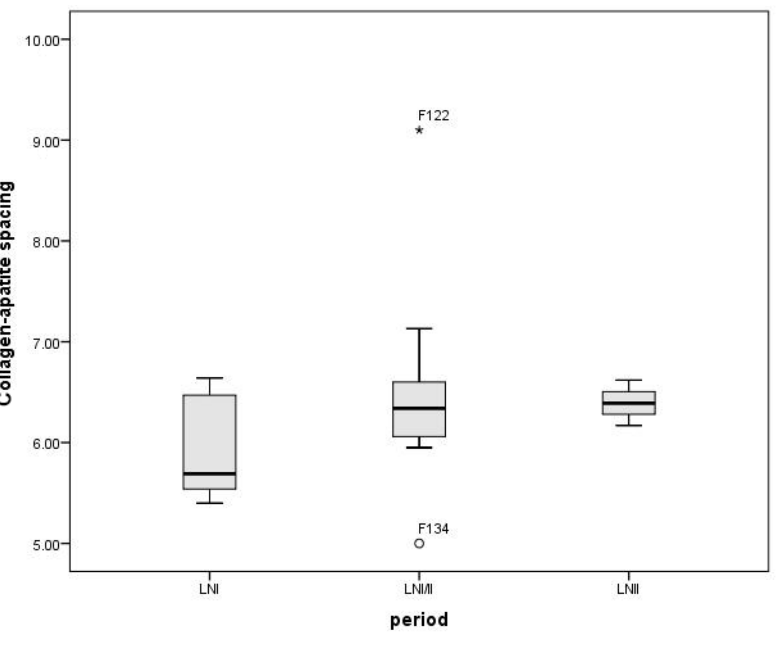
Figure 8. Collagen-apatite spacing from the 17 individuals in Falköping stad 5, included in the diet investigation. Boxplot with line: median, box: 25 th - 75 th percentile, whisker: ca 95% of the data. LNI: Late Neolithic I, LNII: Late Neolithic II.